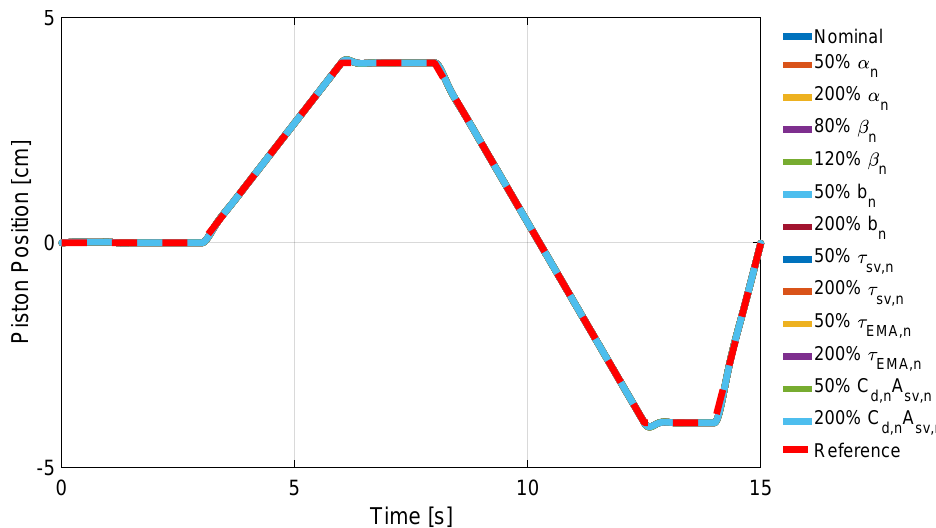
Figure 6. Simulation #1: Piston Position compared to the reference position.